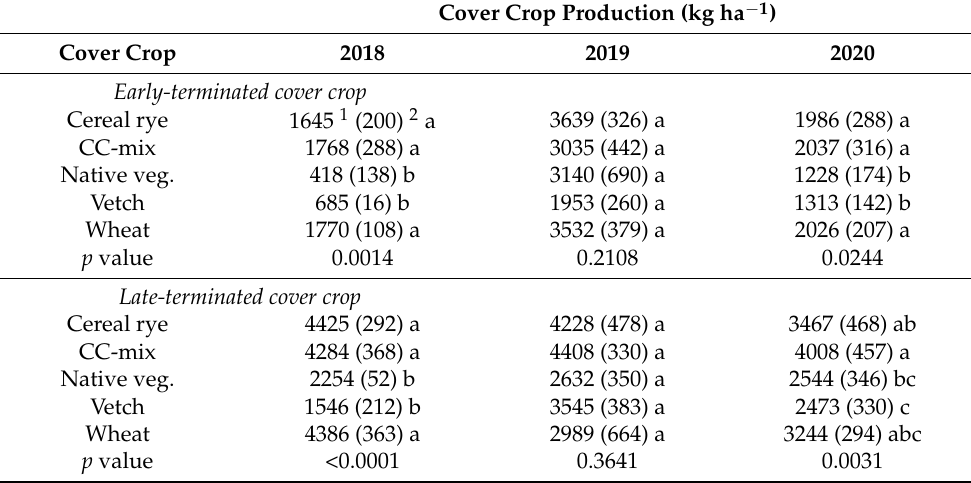
Table 4. Main effects of cover crop on cover crop production in 2018, 2019 and 2020 and average soybean yield in early and late-terminated cover